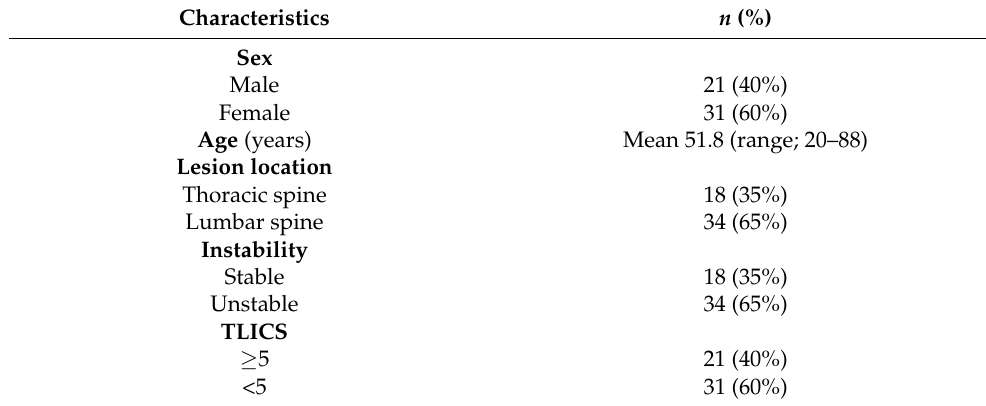
Table 1. Patient and thoracolumbar burst fracture characteristics ( n = 52).